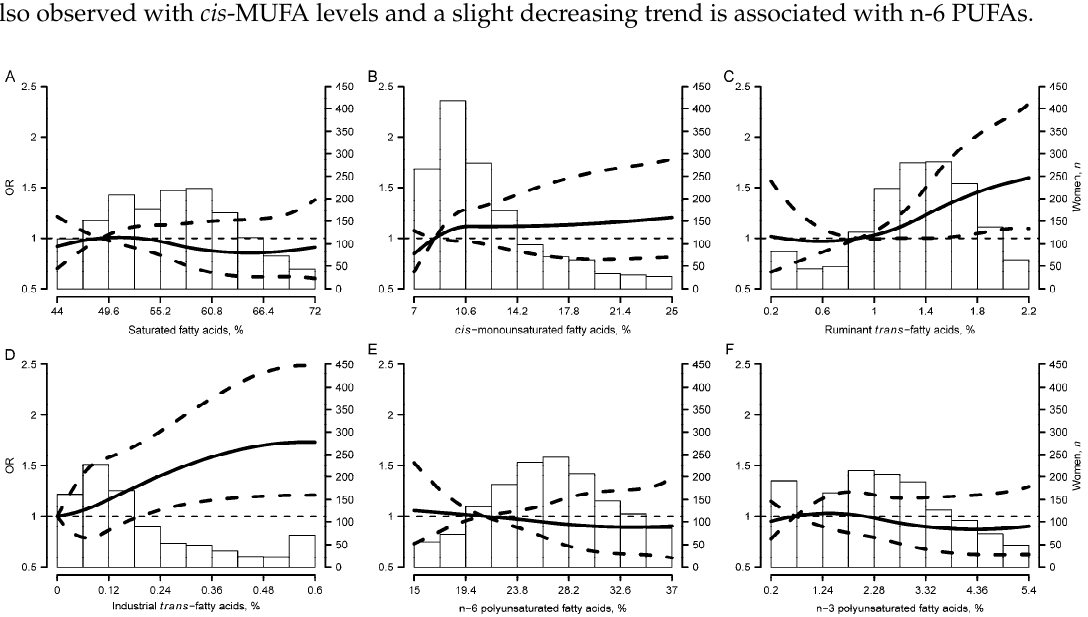
Figure 1. Breast cancer risk as a smooth function of serum phospholipid fatty acids. Curves represent adjusted odds ratios (solid lines) and 95% confidence intervals (dashed lines) based on restricted quadratic splines for ( A ) saturated fatty acids, ( B ) cis- monounsaturated fatty acids, ( C ) ruminant trans − fatty acids, ( D ) industrial trans − fatty acids, ( E ) n-6 polyunsaturated fatty acids and ( F ) n-3 polyunsaturated fatty acids, with knots at their 5th, 50th and 95th percentiles. The reference value for each group of fatty acids was set at the median of the first tertile (56.4%, 10.9%, 1.3%, 0.1%, 26.6% and 2.4% respectively). Odds ratios were obtained from conditional logistic regression models adjusted for educational level, body mass index one year prior to the interview, menopausal status, age at menarche, age at first birth, hormone replacement therapy use, alcohol consumption, self-assessed physical activity during the previous year, history of benign breast disease, family history of breast cancer and caloric intake. Bars represent the histogram of each group of fatty acids.